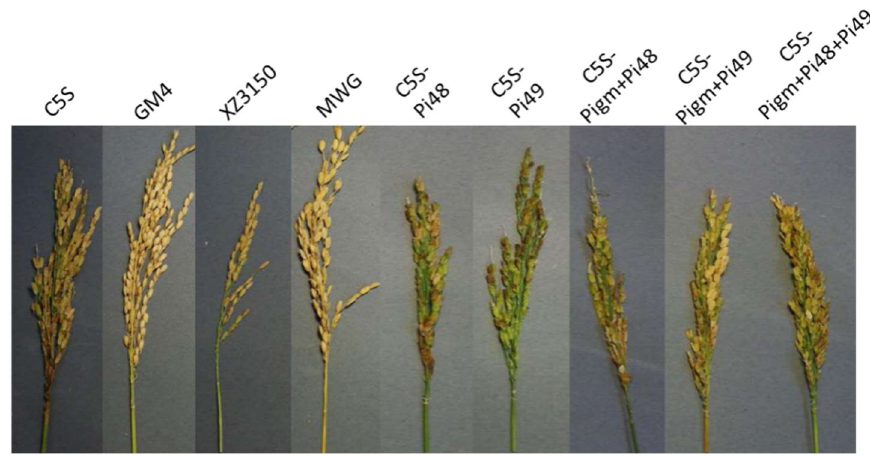
Figure 3. Panicle blast resistance of C5S and the improved lines at grain filling stage.